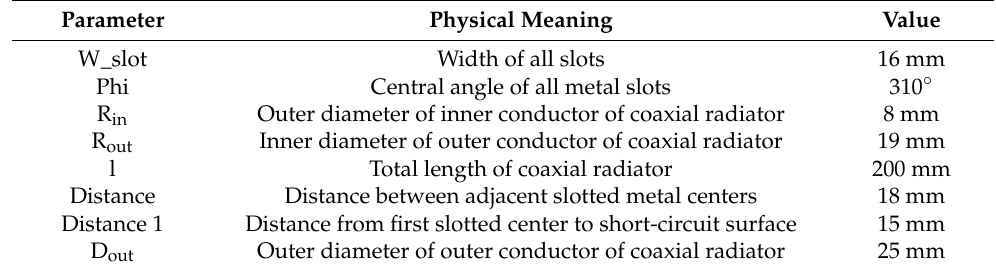
Table 2. Optimized dimensions of experimental equipment.